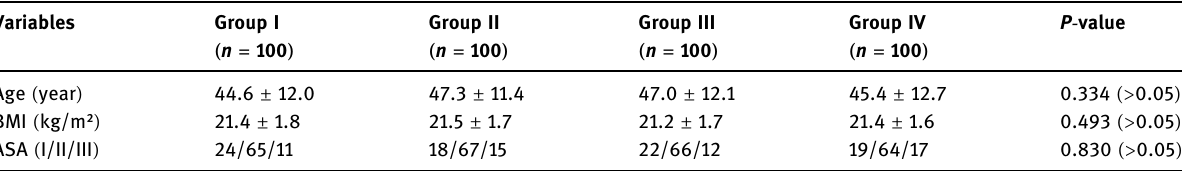
Table 1: Patient characteristics Variables